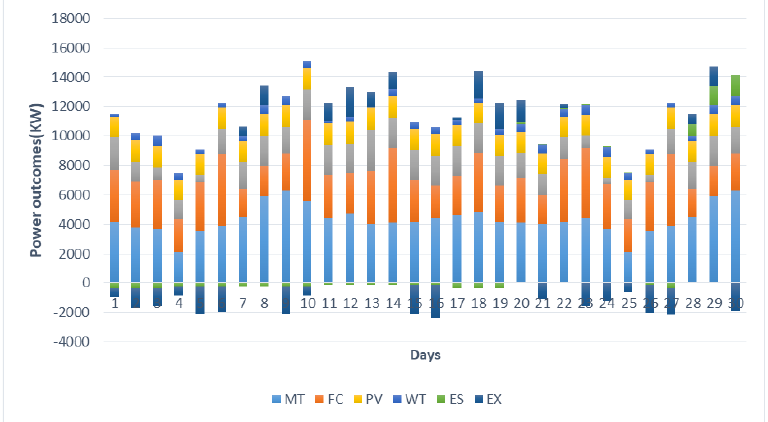
Figure 11. The microgrid’s typical monthly recourse load outputs.